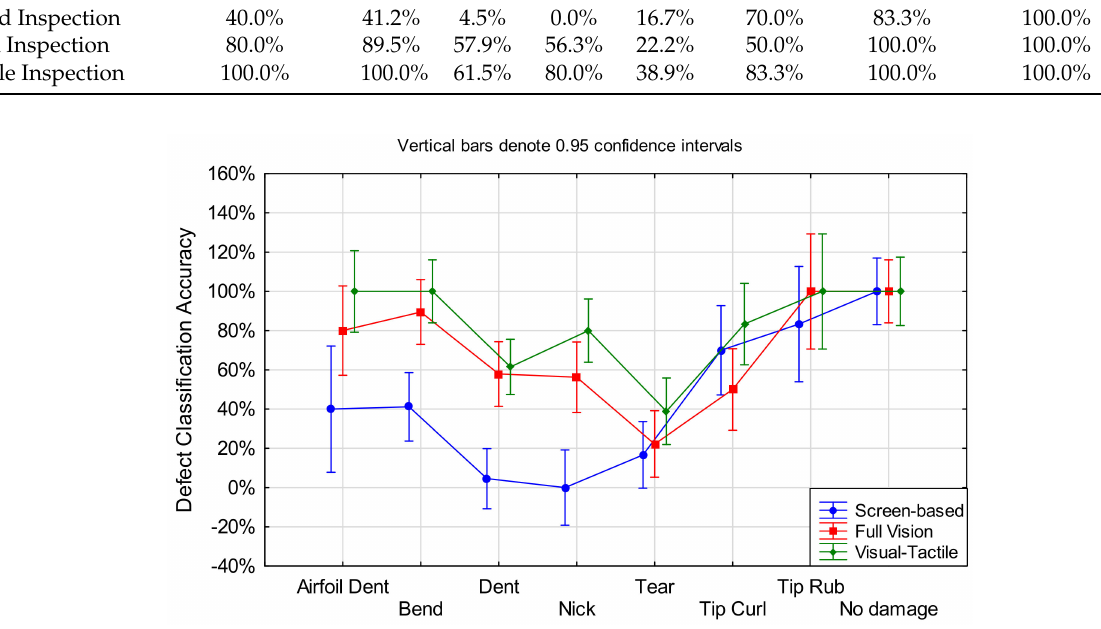
Figure 9. Mean plot of defect classification accuracy by defect type for all inspection methods. Tears were frequently confused with breakage, particularly when a piece of the blade was torn off. Since tears showed a 100% detection rate in all inspection methods, no tears were missed. Confusing tears with material separation (breakage) or cracks is not of great concern, since the maintenance and repair actions are the same for all three defect